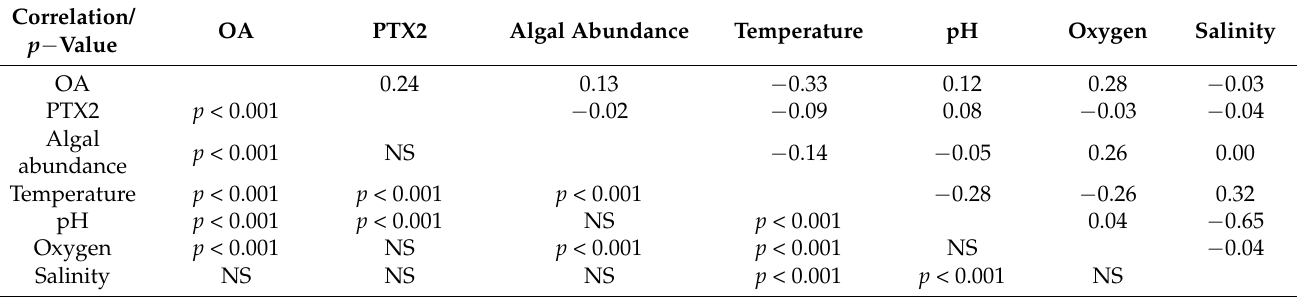
Table 8. Spearman correlation matrix with correlation coefficients and their p